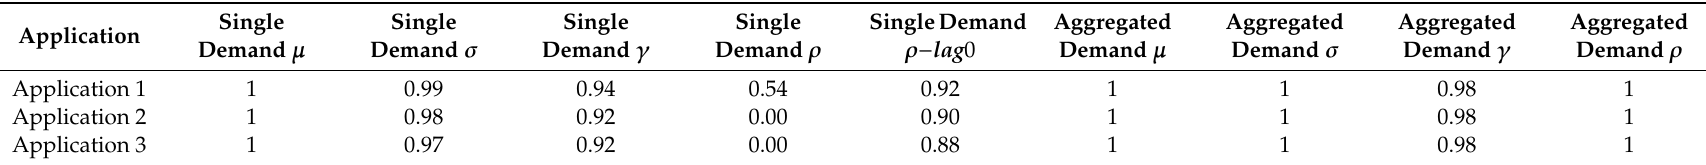
Table 2. Comparison of mean values µ , standard deviation values σ , skewness γ , rank cross-correlations ρ and ρ − lag 0 of measured and generated hourly demands, evaluating the fit in terms of R 2 at both single and aggregated scales, for each application of top-down procedure to Case study 2.